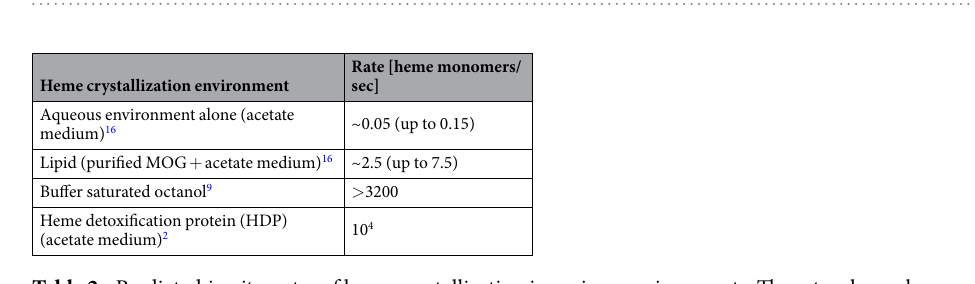
Table 2. Predicted in vitro rates of heme crystallization in various environments. The rates shown here were calculated based on published results 2, 9, 16 (see SI for the detailed calculations).